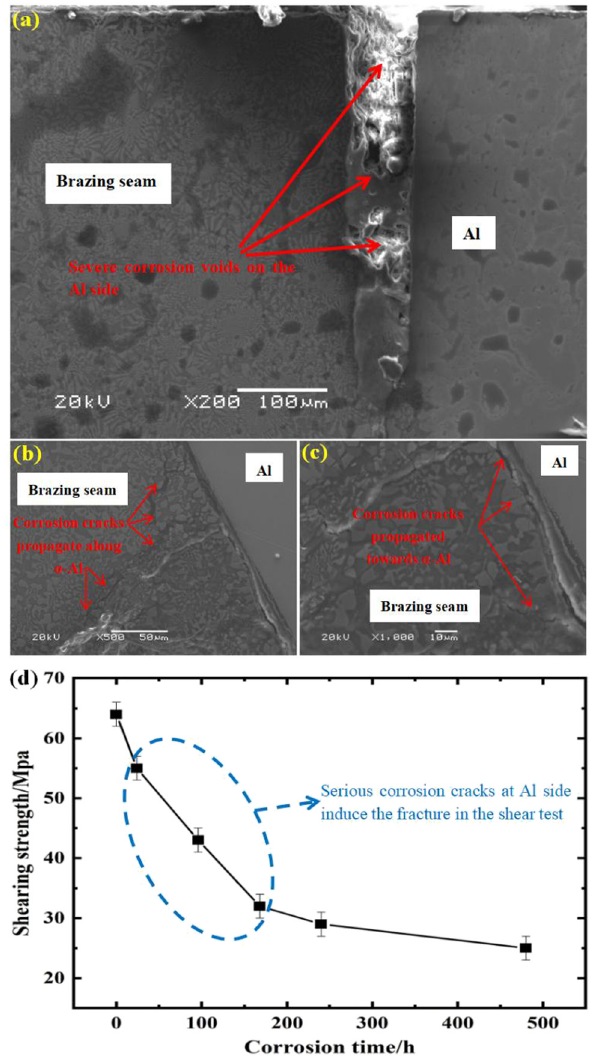
Figure 11: ( a ) Typical microstructure of brazing seam after salt spray test, ( b ) microstructure of corrosion crack propagation in the Brazed joint, ( c ) enlarged image of ( b ) , and ( d ) shearing strength of joints brazed after salt spray